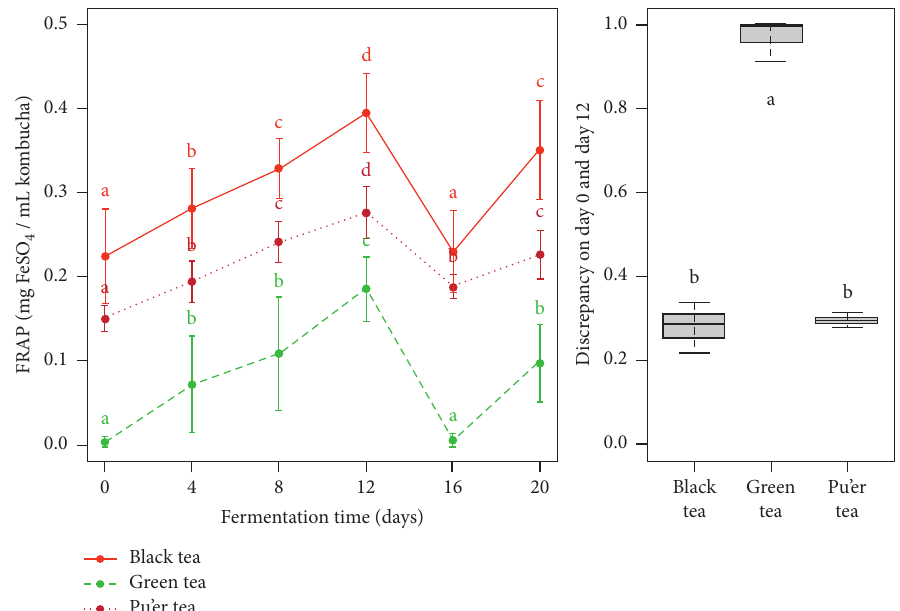
Figure 4: Antioxidant activity assayed using the ferric ion reducing power (FRAP) method (a) and discrepancy value (b) during fer- mentation of kombucha prepared from green, black, and pu’er teas. Different letters indicate significant differences between the tea groups ( p < 0 . 05).